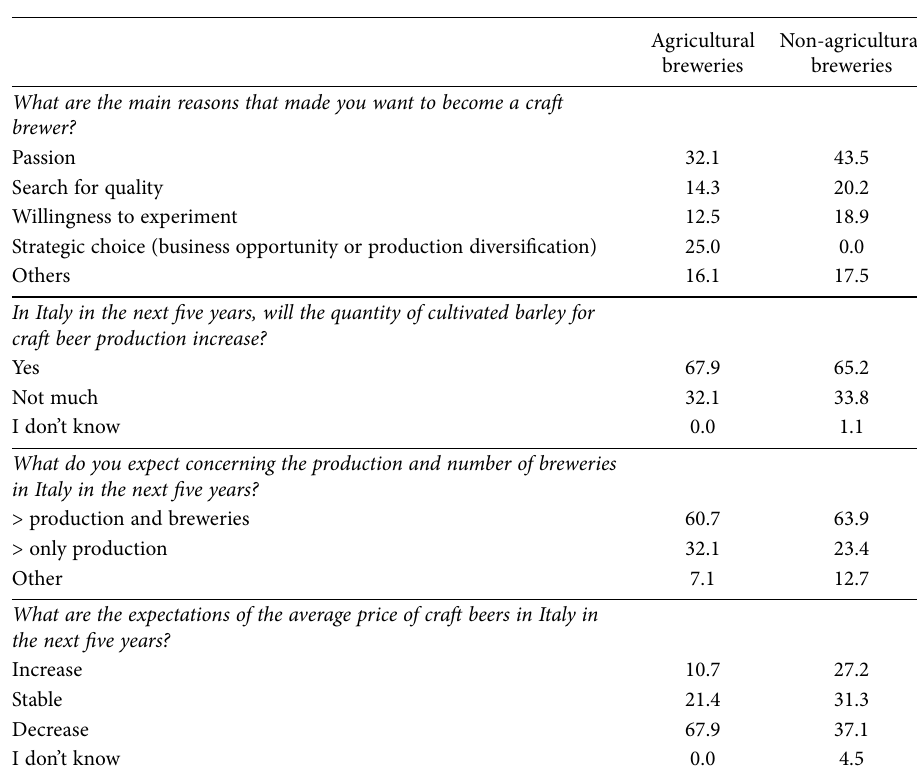
Table 7. Motivations and expectations: comparison between survey responses of agricultural and non- agricultural breweries (% of